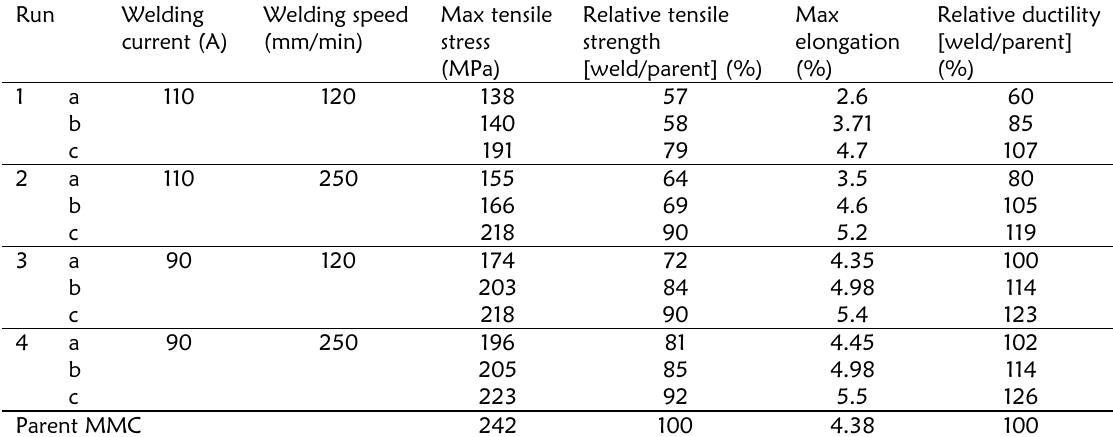
Table 4: Factorial experiment. Tensile test results with three replicates.